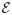
Re-analysis of amino acid sequences in the D region of 14 Zebrafish.A. Proportion of the variance explained by sequence length (PEEV) for the 14 datasets. Most are low, and all but two are less than 0.5. B and C. Zipf plots for the dataset with the lowest (B) and highest (C) PEEV. In both plots the black line uses all the data and the coloured lines correspond to sequence lengths ranging from 1 to 7. The red line has a slope of −1, and so corresponds to Zipf’s law. Data from Ref. [5], kindly supplied by Thierry Mora. (Note that E increases downward on the y-axis, in keeping with standard conventions).